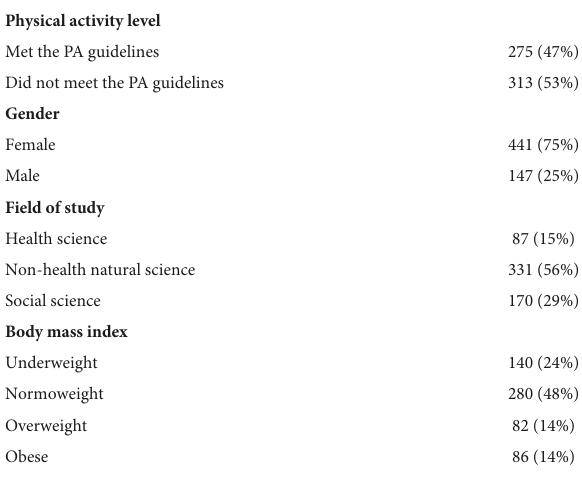
TABLE 2 Participants’